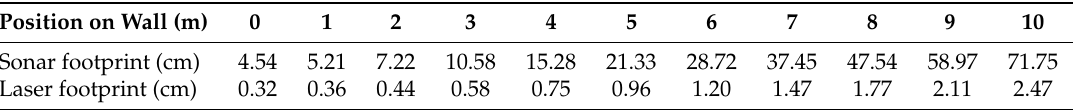
Table 1. Horizontal size of the sonar/laser footprint on a vertical wall located 2.6 m in front of the sensor vs. the horizontal position of the measured point on the wall, i.e., its distance to the orthogonal projection of the sensor on the